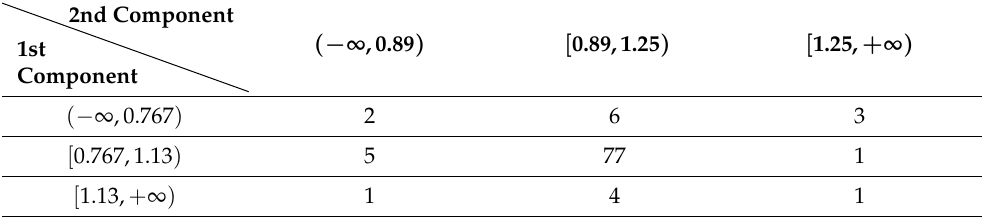
Table 2. Frequency table of the particle distribution over the suggested grid at the end of t = 9. Component2nd Component ( − ∞ ,0.89 1st